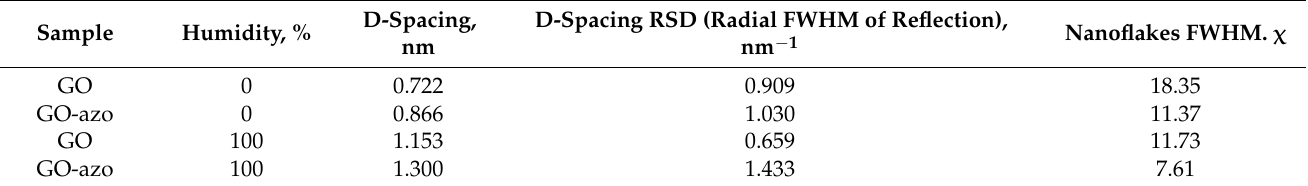
Table 1. GIWAXS data for interlayer spacing and interlayer spacing dispersion in radial and azimuthal direction for pure graphene oxide and azo-GO